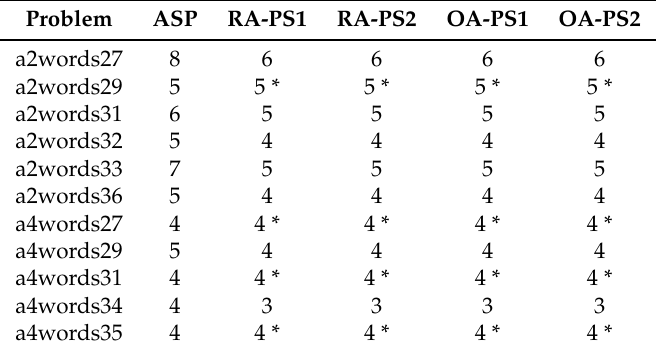
Table 4. Sizes of NFAs reached by the parallel algorithms. The sign * means that the time limit was